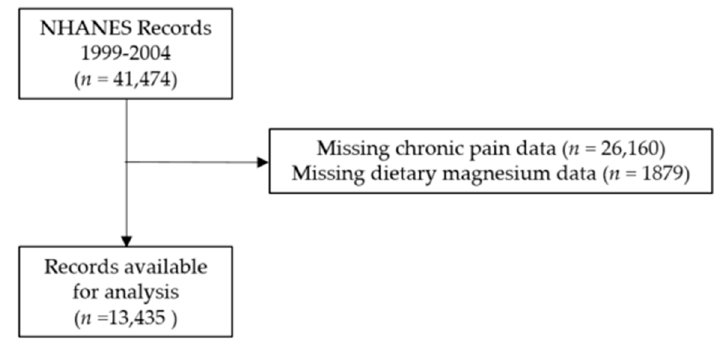
Figure 1. Consort diagram. National Health and Nutrition Examination Survey (NHANES) .